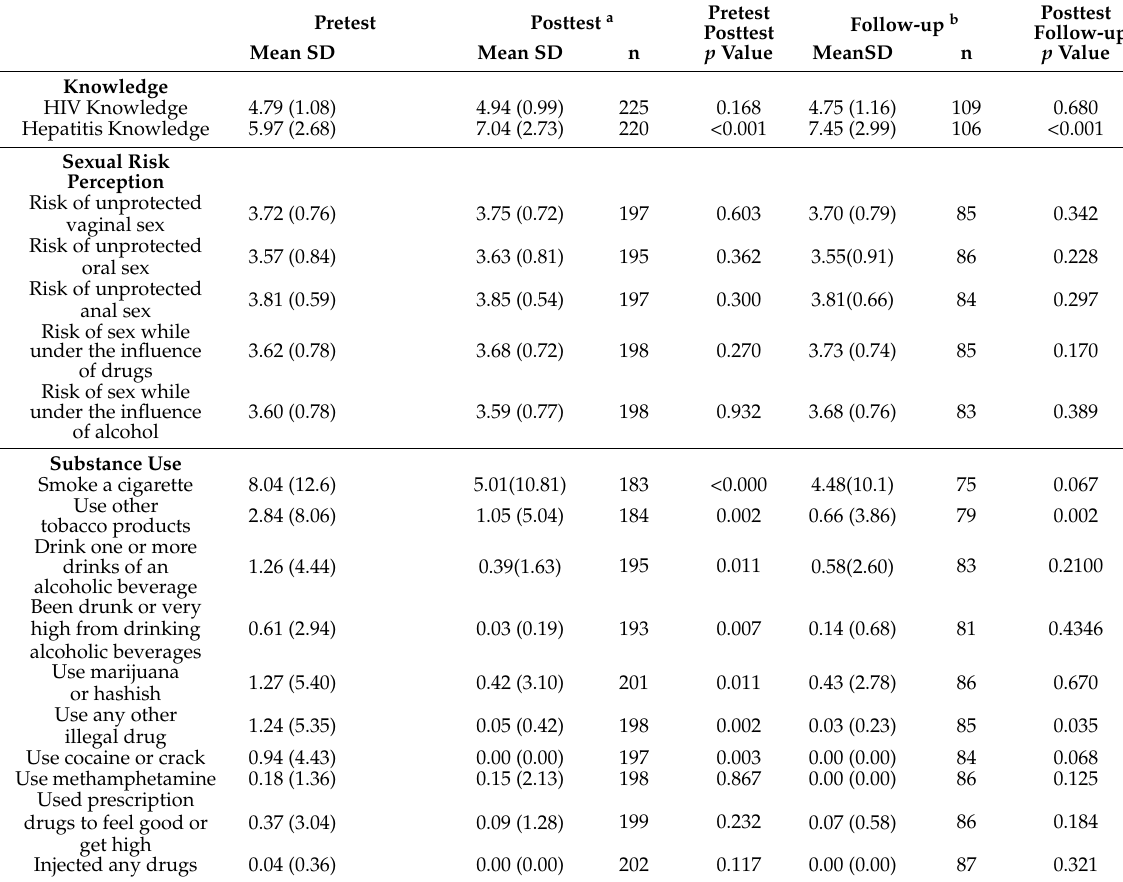
Table 3. HEAL program participant outcomes at pre-test, immediate post-test, and follow-up survey.